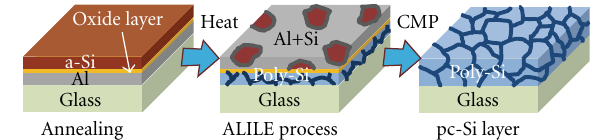
Figure 1: Schematic of the ALILE process.